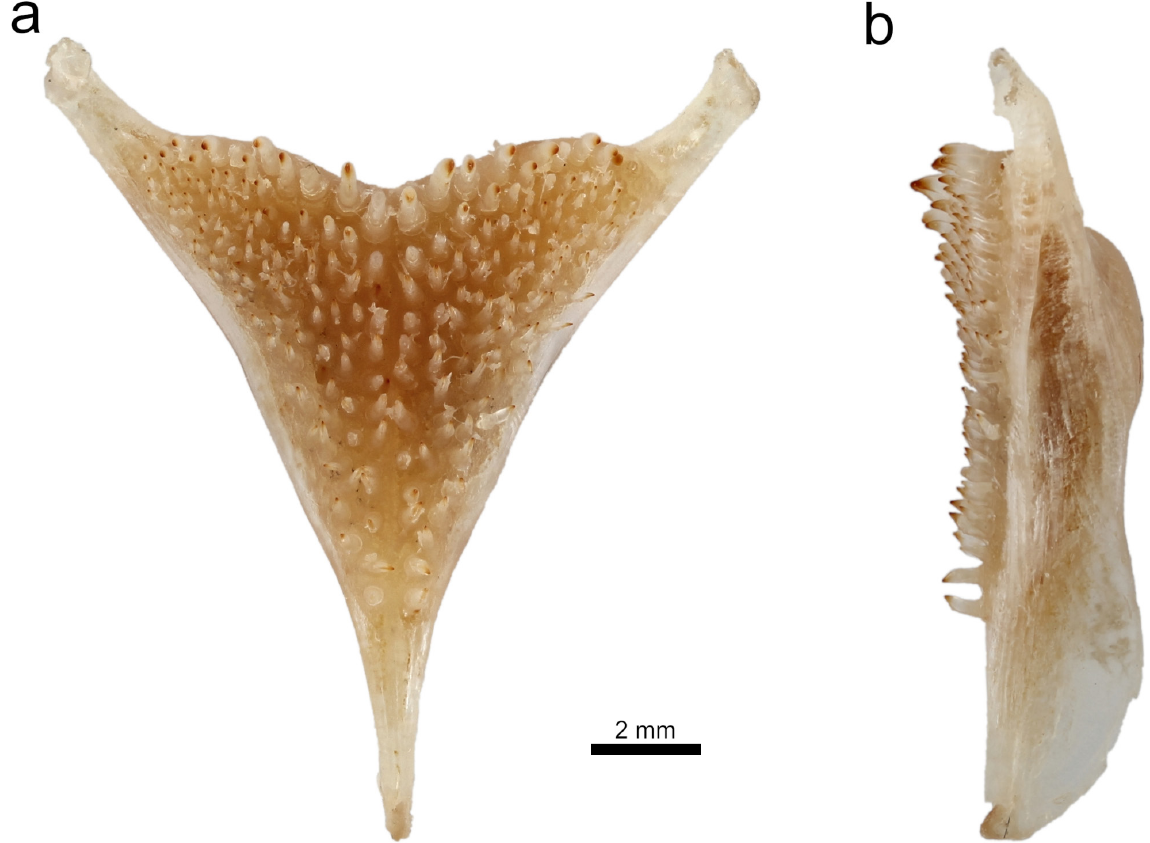
Fig. 37. Haplochromis quasimodo sp. nov. (RMCA 2018.008.P.0337; 126.2 mm SL). a . Dorsal view of the lower pharyngeal jaw. b . Lateral view of the lower pharyngeal